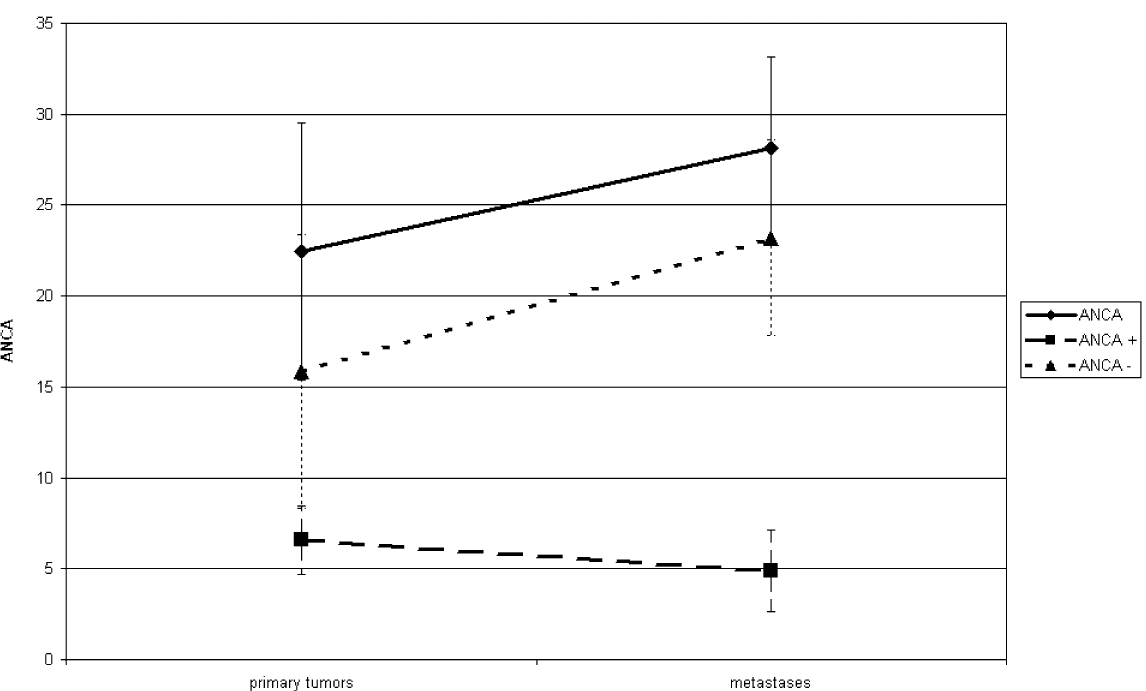
Fig. 5. Averaged number of copy alterations (ANCA) for the comparison of primary tumors and their corresponding distant metastases. The vertical lines represent the standard